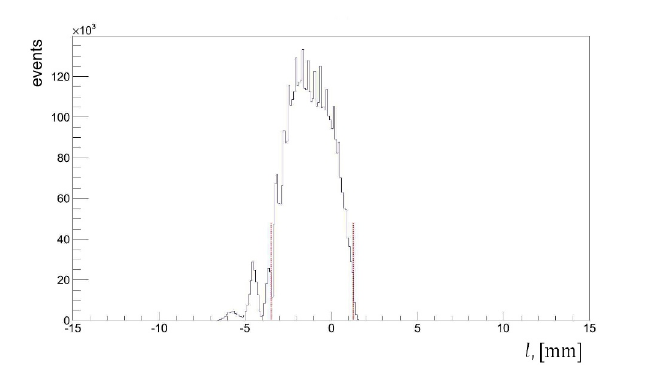
Figure 2. Position of the interaction point of the beam in the target. The solid line represents a graphical cut for the selection of dp-elastic scattering events